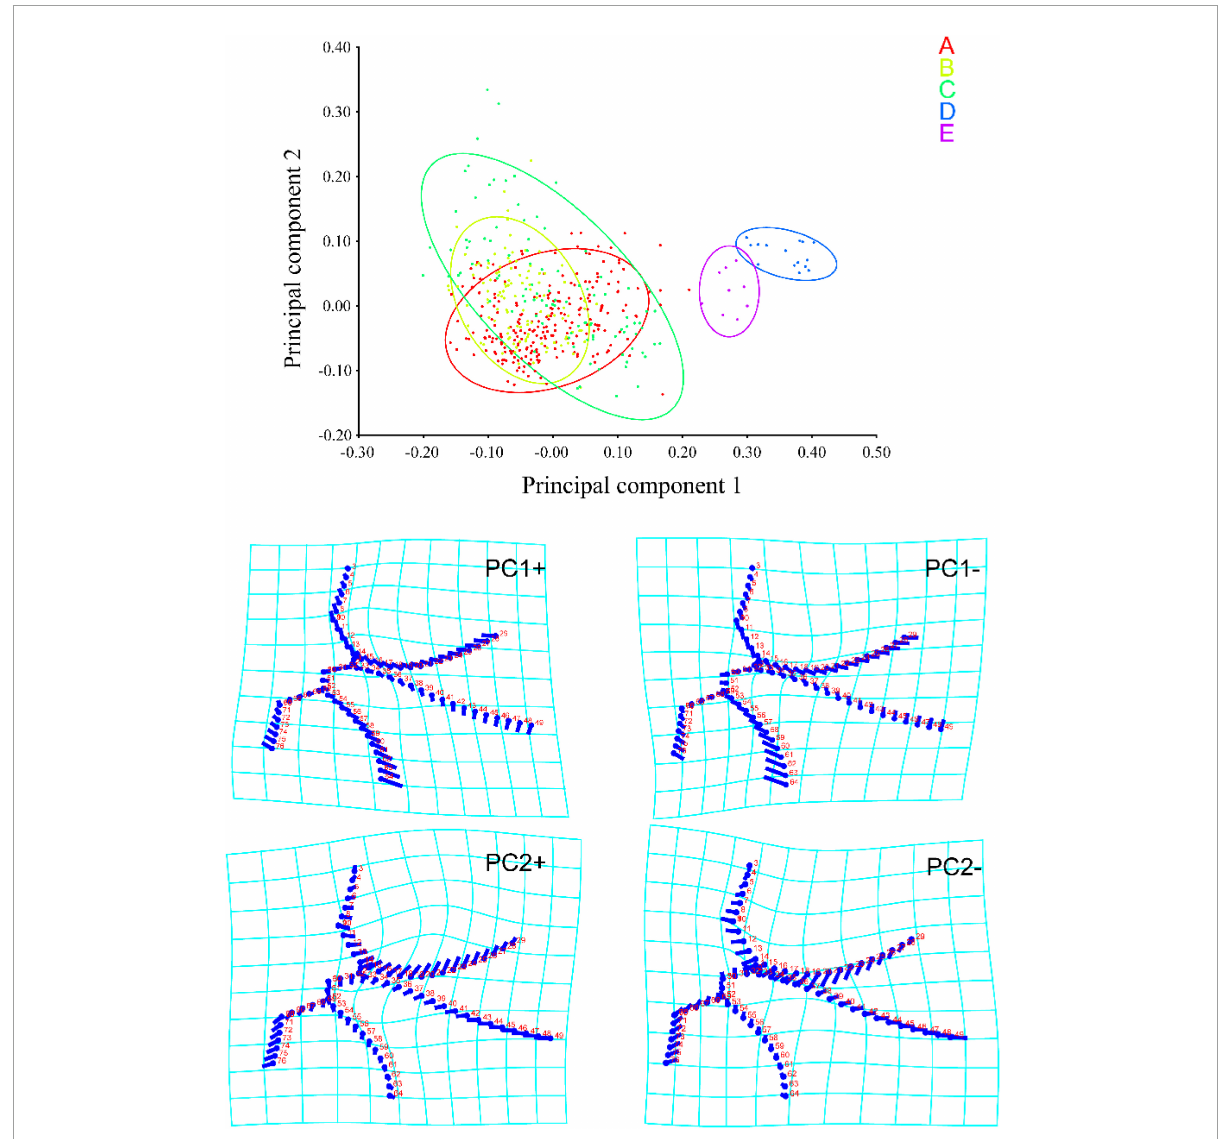
FIGURE2 Principal component analysis (PCA) scores and shape changes of the four tribes of Typhlocybinae: A, Typhlocybini (2 hind wing crossveins); B, Typhlocybini (3 hind wing crossveins); C, Zyginellini; D, Erythroneurini, E, Empoascini.